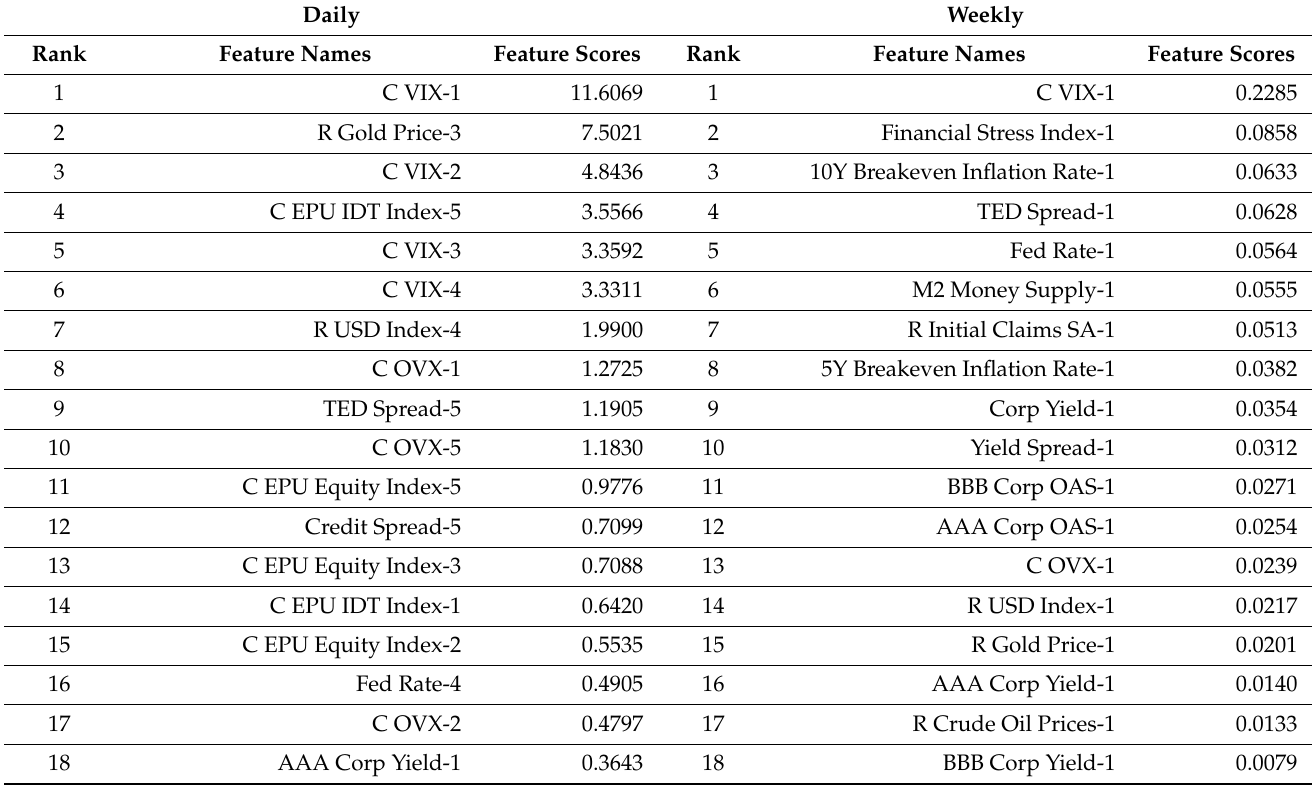
Table A1. Complete list of ranked features and their score from Light GBM models. Numbers are truncated to four decimal